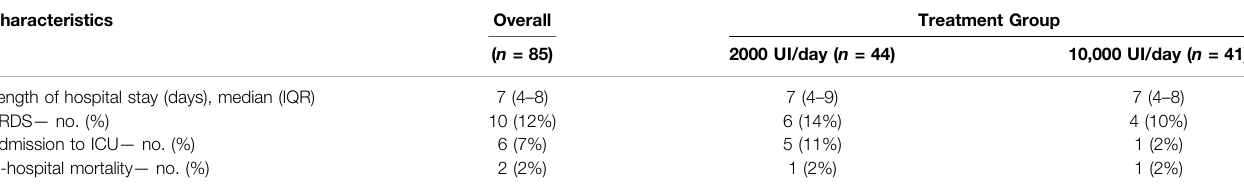
TABLE 2 | Clinical characteristics in hospitalized patients with COVID-19 who received 2000 IU/day and 10,000IU/day of cholecalciferol.